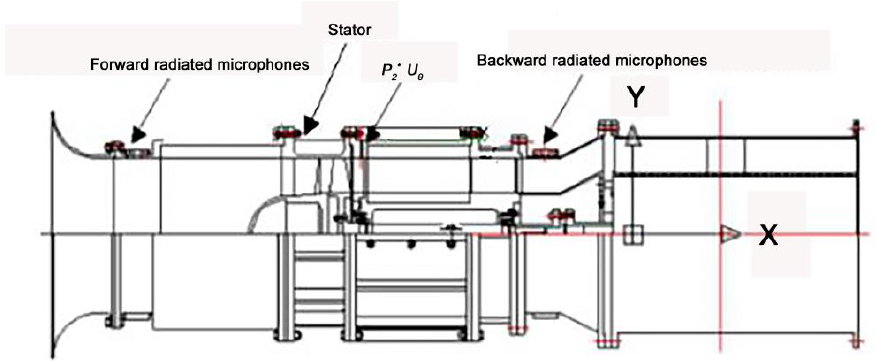
Figure 2. Single-stage low-speed axial compressor.